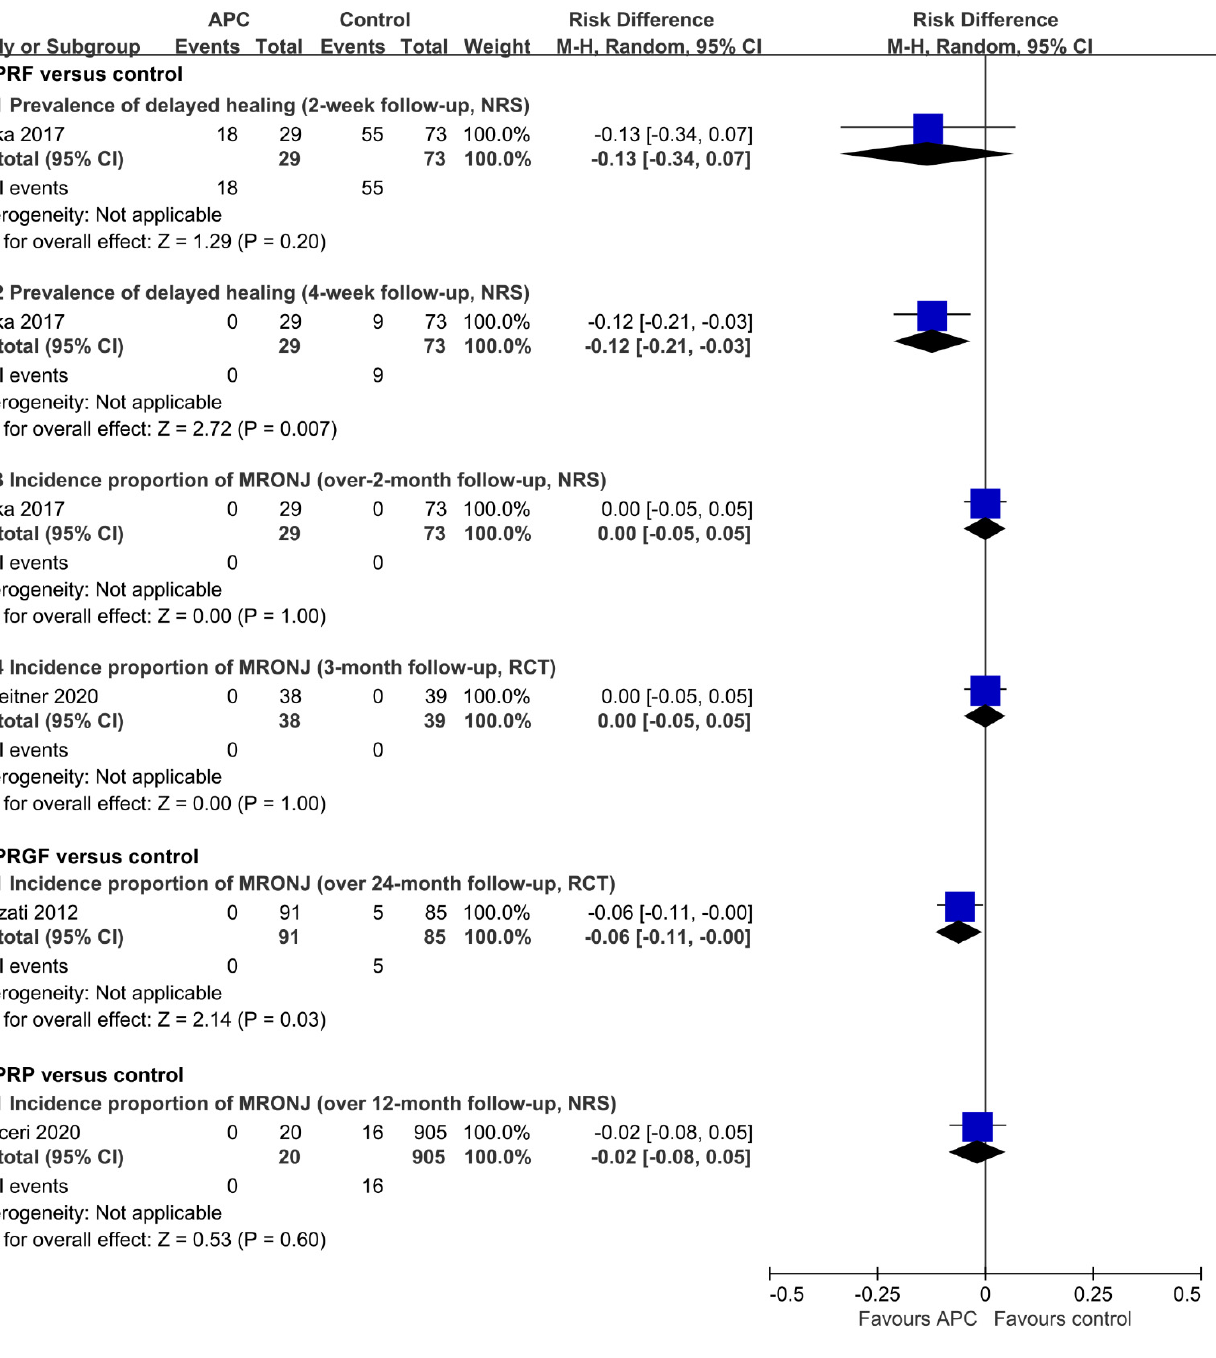
Figure 6. Forest plot of Comparison 2 (APC versus control) [27,30,32,33].